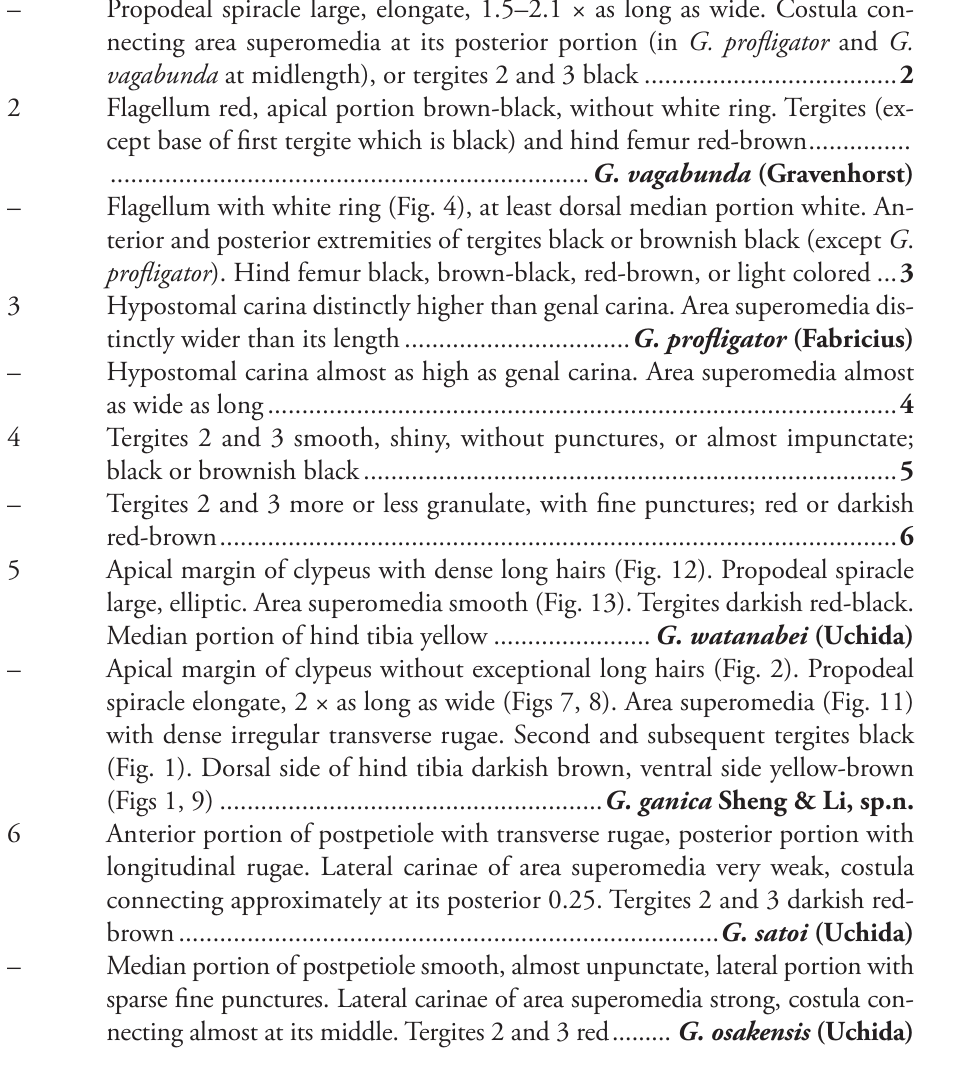
Key to species of Glyphicnemis recorded from Asia (Oriental and Eastern Palaearctic Regions) (Female only) 1 Propodeal spiracle small, semicircular, 1.3–1.5 × as long as wide. Costula connecting area superomedia approximately at its middle. Tergites 2 and 3 usually reddish brown. ..................................................... G. atrata (Strobl) – Propodeal spiracle large, elongate, 1.5–2.1 × as long as wide. Costula con- necting area superomedia at its posterior portion (in G. profligator and G. vagabunda at midlength), or tergites 2 and 3 black ..................................... 2 2 Flagellum red, apical portion brown-black, without white ring. Tergites (ex- cept base of first tergite which is black) and hind femur red-brown ............... ...................................................................... G. vagabunda (Gravenhorst) – Flagellum with white ring (Fig. 4), at least dorsal median portion white. An- terior and posterior extremities of tergites black or brownish black (except G . profligator ). Hind femur black, brown-black, red-brown, or light colored ... 3 3 Hypostomal carina distinctly higher than genal carina. Area superomedia dis- tinctly wider than its length ................................. G. profligator (Fabricius) – Hypostomal carina almost as high as genal carina. Area superomedia almost as wide as long ............................................................................................ 4 4 Tergites 2 and 3 smooth, shiny, without punctures, or almost impunctate; black or brownish black .............................................................................. 5 – Tergites 2 and 3 more or less granulate, with fine punctures; red or darkish red-brown ................................................................................................... 6 5 Apical margin of clypeus with dense long hairs (Fig. 12). Propodeal spiracle large, elliptic. Area superomedia smooth (Fig. 13). Tergites darkish red-black. Median portion of hind tibia yellow ....................... G. watanabei (Uchida) – Apical margin of clypeus without exceptional long hairs (Fig. 2). Propodeal spiracle elongate, 2 × as long as wide (Figs 7, 8). Area superomedia (Fig. 11) with dense irregular transverse rugae. Second and subsequent tergites black (Fig. 1). Dorsal side of hind tibia darkish brown, ventral side yellow-brown (Figs 1, 9) ........................................................ G. ganica Sheng & Li, sp.n. 6 Anterior portion of postpetiole with transverse rugae, posterior portion with longitudinal rugae. Lateral carinae of area superomedia very weak, costula connecting approximately at its posterior 0.25. Tergites 2 and 3 darkish red- brown ............................................................................... G. satoi (Uchida) – Median portion of postpetiole smooth, almost unpunctate, lateral portion with sparse fine punctures. Lateral carinae of area superomedia strong, costula con- necting almost at its middle. Tergites 2 and 3 red ......... G. osakensis